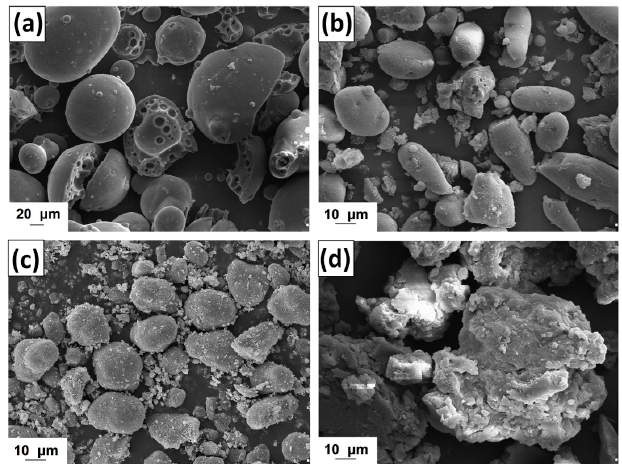
Figure 2. Scanning electron microscopy (SEM) images of lignin ( a ) and lignins activated by [C 4 im][HSO 4 ] ( b ), [Et 3 NH][HSO 4 ] ( c ) and [C 4 C 1 im][MeSO 3 ] ( d ).